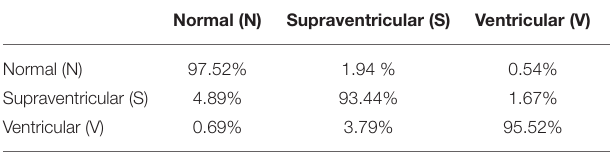
TABLE 7 | Confusion Matrix of total classified beats in